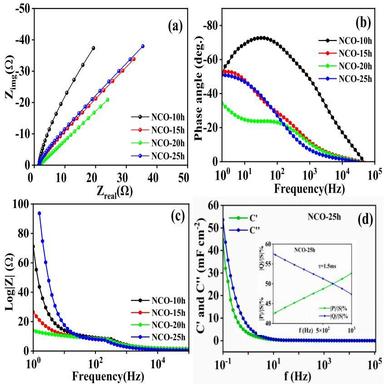
(a) Nyquist plot of all four NCO samples at a potential of 5 mV (b) plot of phase angle vs. frequency (c) Plot of log |Z| versus frequency (f), and (d) real and imaginary capacitances (C′ and C″) vs. frequency (log f) of NiCo2O4 electrode with 2 M KOH electrolyte.